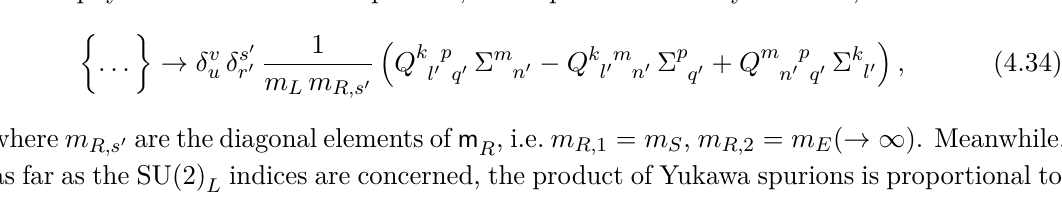
Figure 3 . One-loop diagrams contributing to the dipole operator in the SU(2) theory, in the basis after field redefinition. The three diagrams in the first (second) row have the coupling structure shown in the first (second) term of eq. (4.31) — both terms are related by P and are shown to cancel each